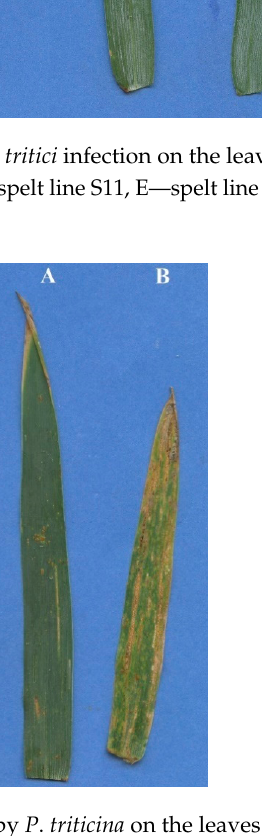
Figure 2. Symptoms of B. graminis f. sp. tritici infection on the leaves of the analyzed wheats A—cv. Torka, B—cv. Zebra, C—cv. Kontesa, D—spelt line S11, E—spelt line S12, F—spelt line S13, G—wheat x spelt line 23 (S13 × K).